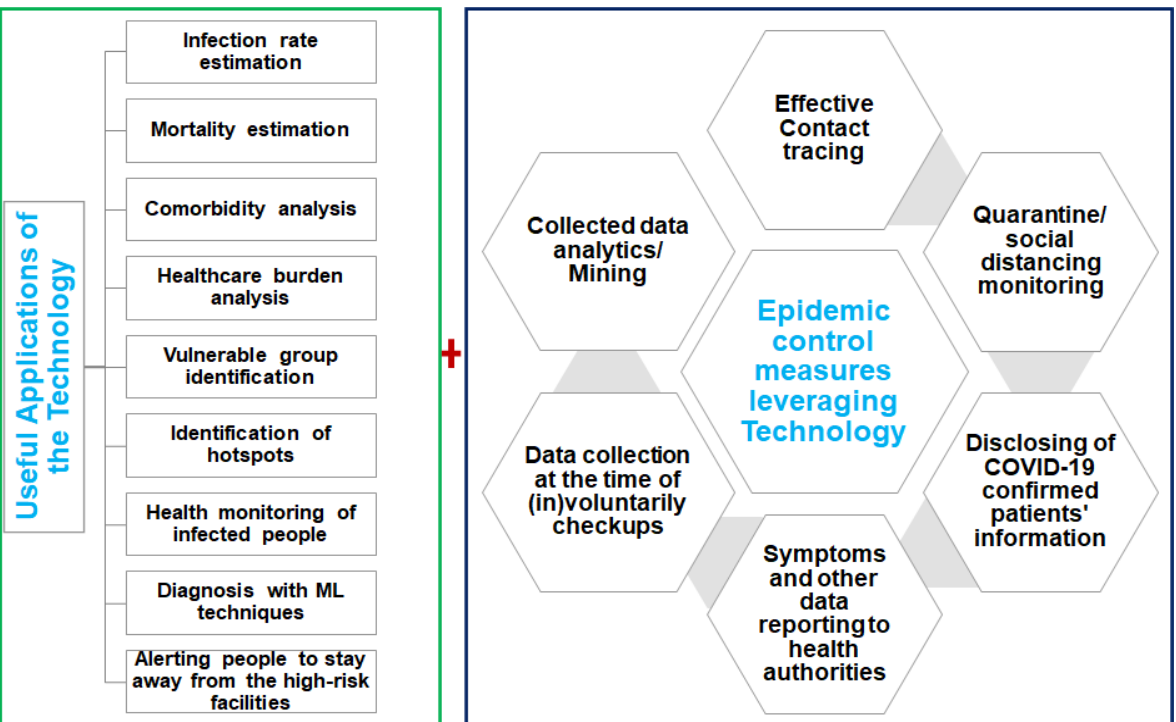
Figure 1. Taxonomy of the epidemic features that demand the utilization of advanced techniques such as ML and HPC.